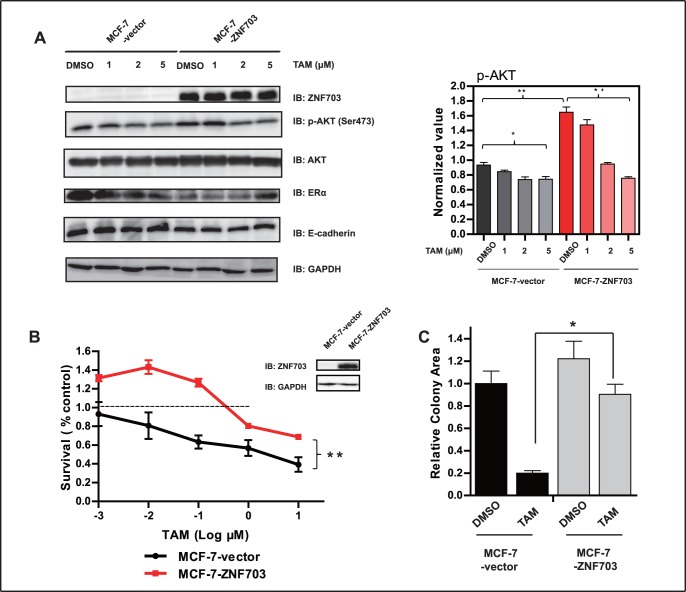
Overexpression of ZNF703 activates p-AKT and induces tamoxifen resistance.(A) MCF-7-vector and MCF-7-ZNF703 cells were treated with DMSO, 1 µM, 2 µM or 5 µM TAM for 24 hours, followed by western blot analysis of the indicated proteins. GAPDH was used as a loading control. ImageJ software was used to measure p-AKT levels and normalize to GAPDH levels (y-axis). (B) Western blot analysis of ZNF703 protein expression in MCF-7-vector and MCF-7-ZNF703 cells. MCF-7-vector and MCF-7-ZNF703 cells were treated with DMSO or different concentrations of TAM for 72 hours and inhibitory rates were examined. (C) Tamoxifen-mediated cell growth inhibition in MCF-7-vector and MCF-7-ZNF703 cells was evaluated by the colony formation assay. MCF-7-vector and MCF-7-ZNF703 cells were treated with DMSO or 1 µM TAM for 15 days, and colony forming areas were calculated to compare the differences before and after administration in both cell lines. Data are representative of three independent experiments and are presented as mean ± SD. *P<0.05, **P<0.01.